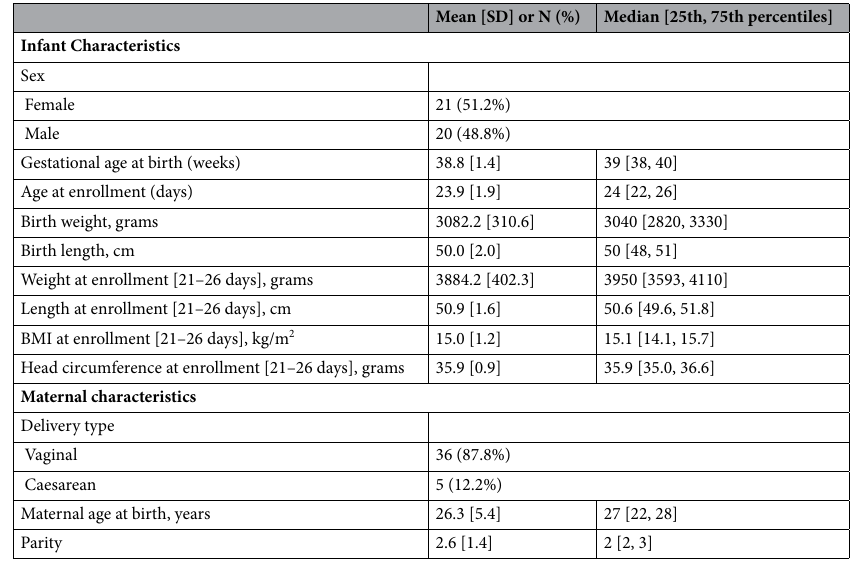
Table 1. Infant and maternal characteristics (N =